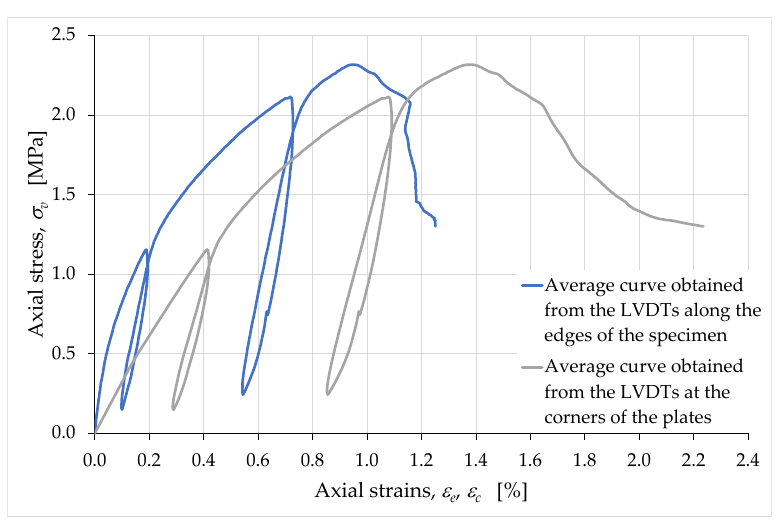
Figure 14. Average curves of the axial stress with respect to the axial strains 𝜀 𝑒 and 𝜀 𝑐 .